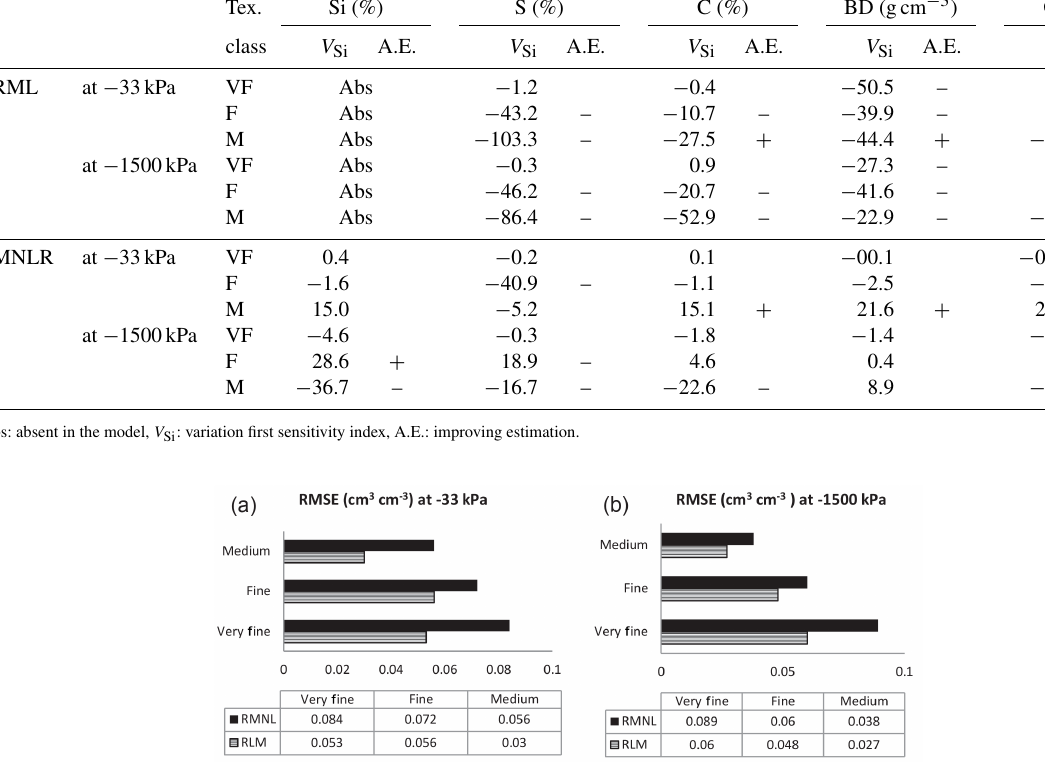
was provided by point PTFs (RMSE = 0.027 cm 3 cm − 3 )